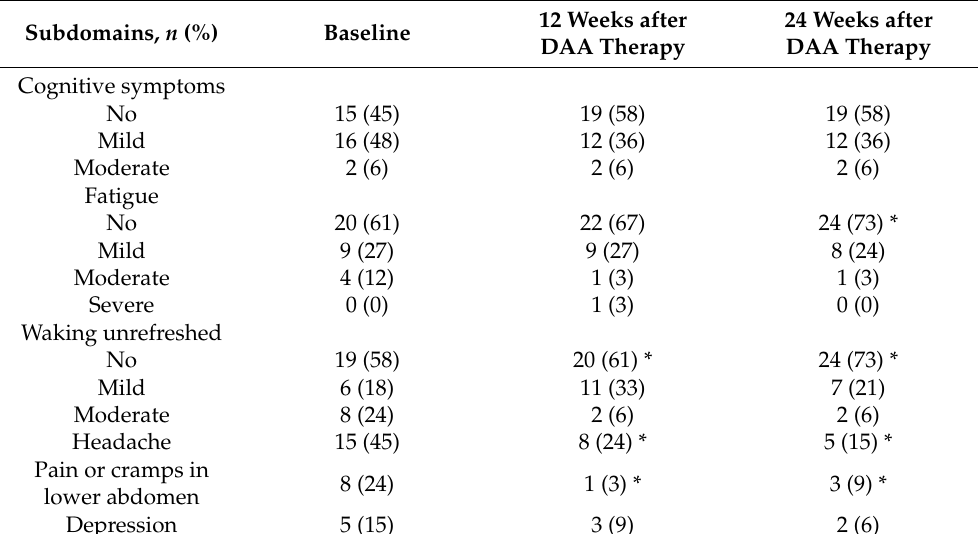
Figure 3. Comparison of ( A ) fibromyalgianess, ( B ) widespread pain index (WPI), and ( C ) symptom severity (SS) score between baseline, 12 and 24 weeks after cessation of DAA therapy in CHC patients. CHC, chronic hepatitis C; DAA, direct-acting antiviral drugs. ** p < 0.001 by the Wilcoxon signed rank test. Table 3. Subdomains in the symptom severity scale at baseline and after DAA therapy in CHC pa ‐ tients.